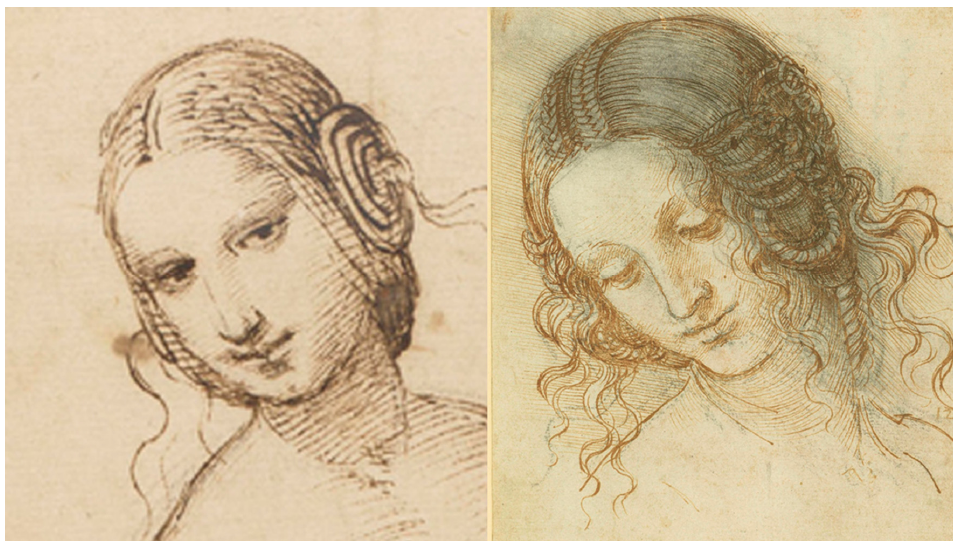
Figure 5. On the left, Raphael, Leda and the Swan , ca. 1507, pen and ink over black chalk under- drawing, 210 × 192 mm, RCIN 912759, Royal Collection, Windsor Castle. Royal Collection Trust/© Her Majesty Queen Elizabeth II 2021. On the right, Leonardo da Vinci, Head of Leda, ca. 1505–1508, black chalk, pen and ink, 177 × 147 mm, RCIN 912518, Royal Collection, Windsor Castle. Royal Collection Trust/© Her Majesty Queen Elizabeth II 2021. Detail of Leda’s head. Comparison be- tween Raphael’s and Leonardo’s drawing. Used with permission.